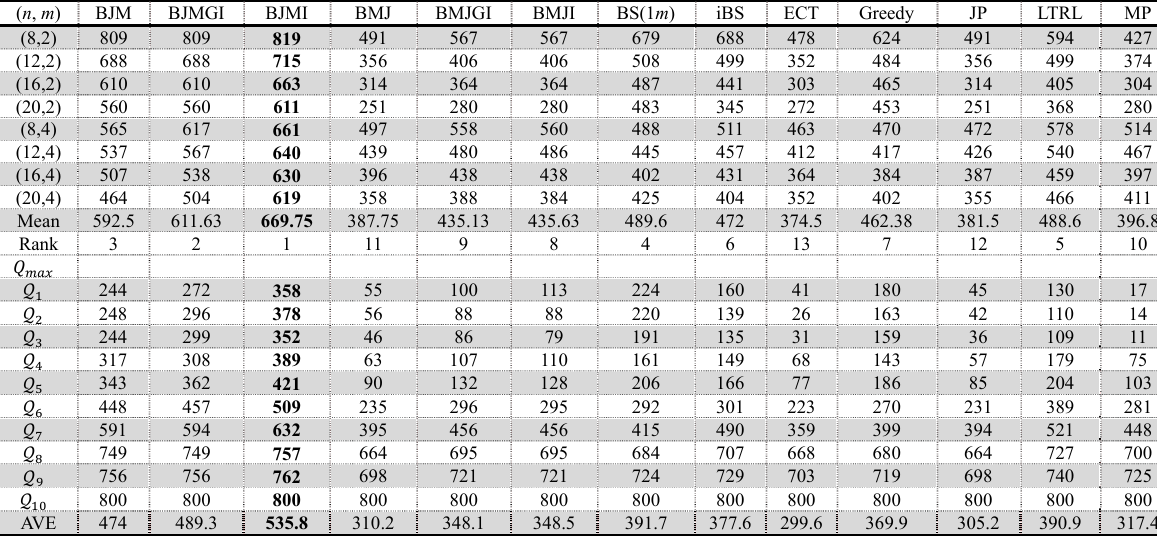
NSR for heuristics(small instance)